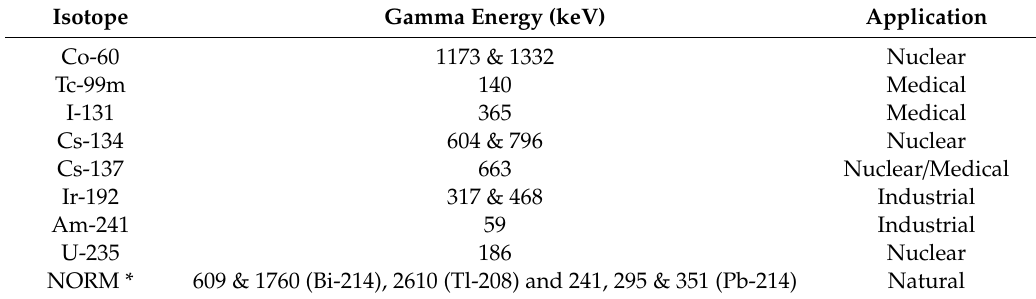
Table 1. Common gamma-ray emitting radionuclides that are most frequently encountered outside of regulatory control, their gamma-ray emission energies and application(s), from